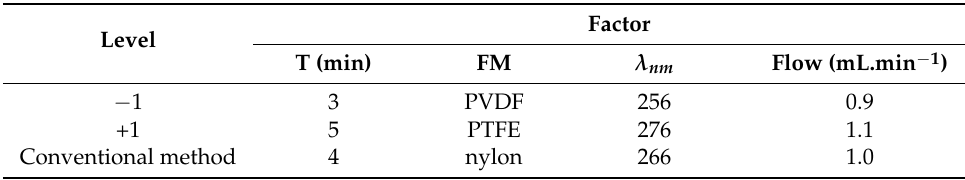
Table 2. Variations made to determine method